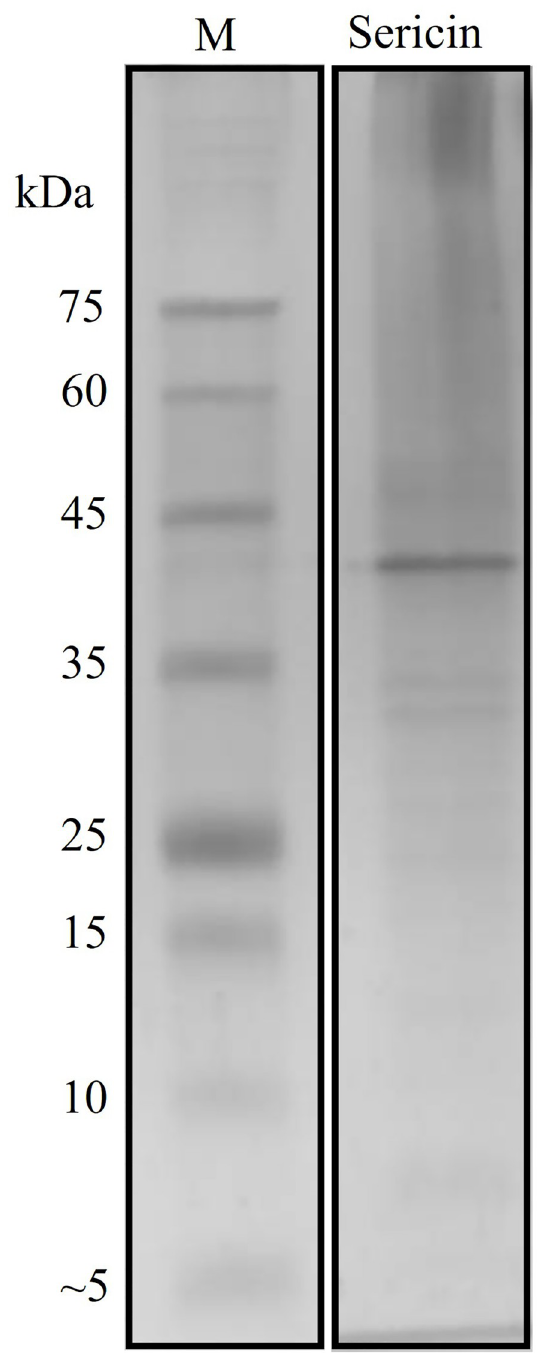
Fig 1. SDS-PAGE analysis of sericin extract. (M) molecular weight marker, (Sericin) Sericin extract. sericin without normal saline, indicating higher system stability. The average particle size in sericin extract with NaCl was approximately ten times smaller than in sericin without NaCl.